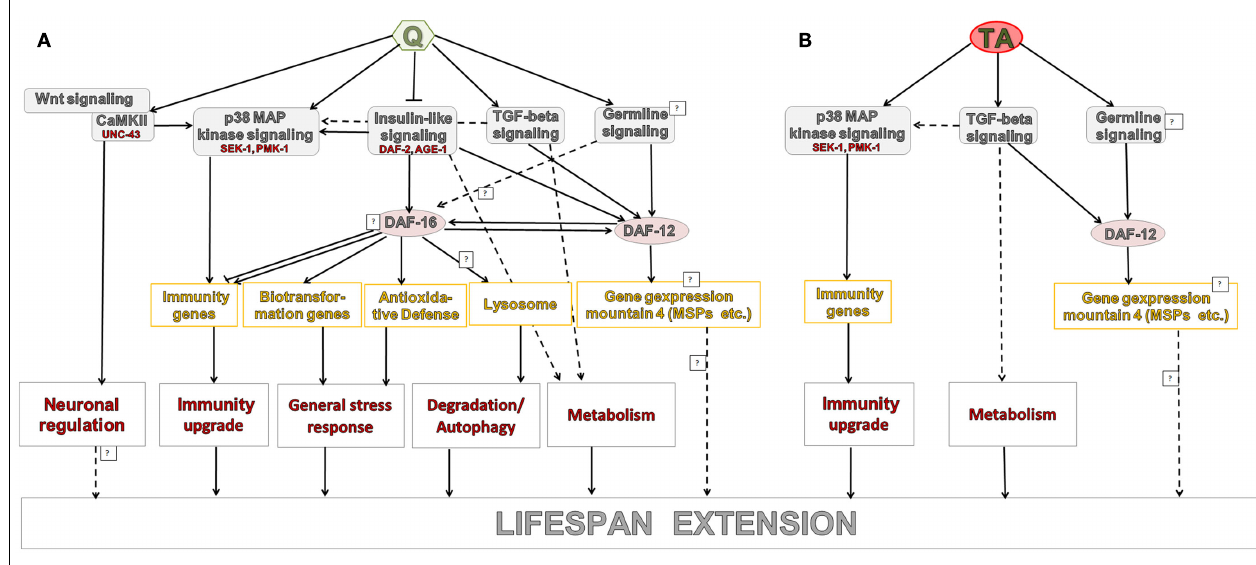
FIGURE 4 | Hypothetical model of Q’s (A) andTA’s (B) mode of